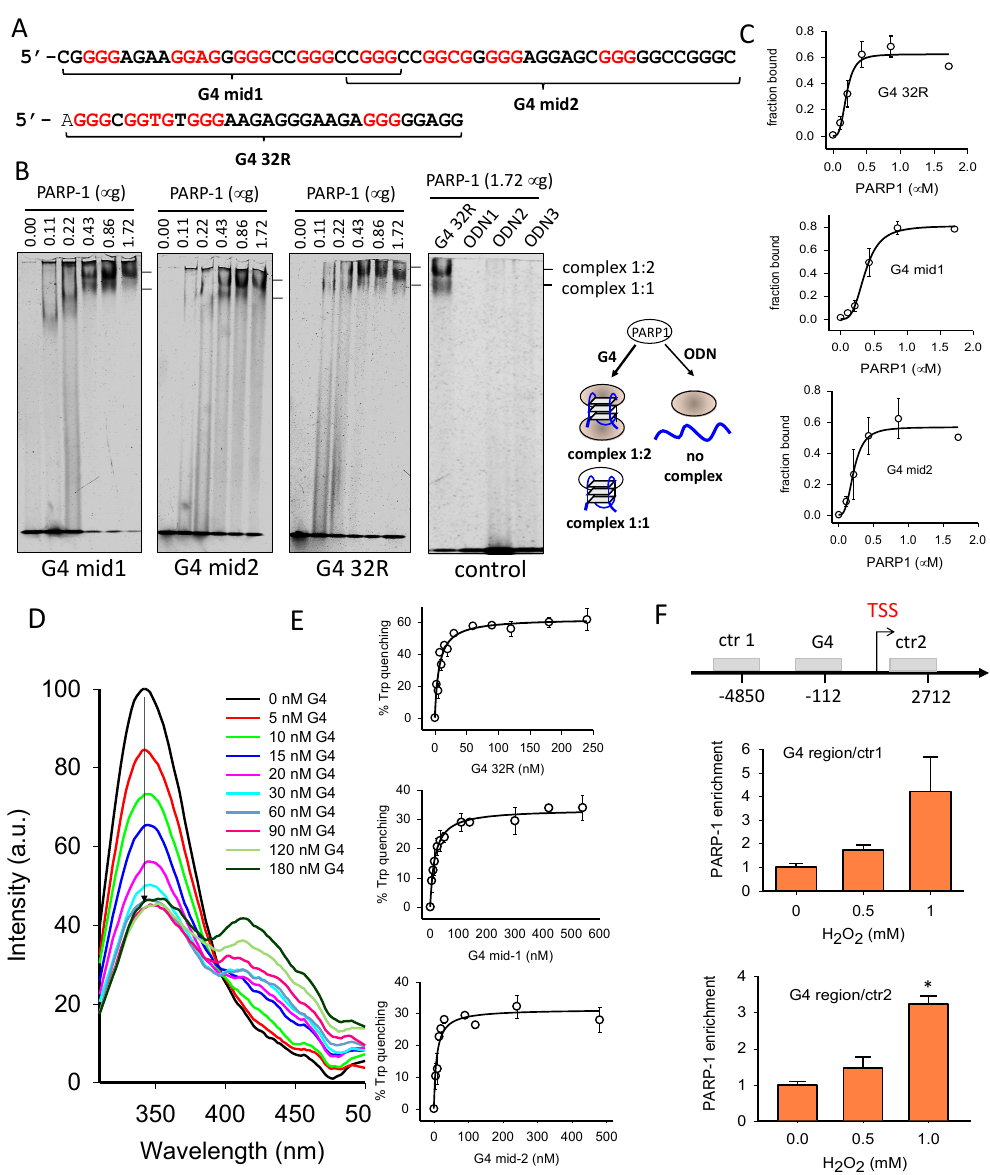
Figure 3. ( A ) Sequences of G4 32R, G4 mid1 and G4 mid2; ( B ) EMSA showing the binding of recombinant PARP-1 to Cy5.5-labelled G4-mid1, G4 mid2, G4 32R and control oligonucleotides ODN1, ODN2 and ODN3 (50 nM), with increasing amounts of PARP-1. Reaction was carried out in 20 mM Tris–HCl pH 8, 30 mM KCl, 1.5 mM MgCl 2 , 1 mM DTT, 8% glycerol, 1% Phosphatase Inhibitor Cocktail I (Sigma, Milan, Italy), 5 mM NaF, 1 mM Na 3 VO 4 , 2.5 ng/mL poly [dI-dC], 50 mM ZnAc for 30 min at RT. 50 nM Cy5.5-labelled G4 was incubated with 0, 0.11, 0.22, 0.43, 0.86, and 1.72 μM PARP-1; ( C ) Plots reporting the fraction of G4 bound to PARP-1 as a function of the PARP-1 concentration. The data have been best-fitted to the Hill equation. Error bars are from two experiments; ( D ) Typical fluorescence titration of PARP-1 with G4 32R. The titration was carried out in a 500 µ L quartz cuvette containing a solution of PARP-1 (60 nM) in 50 mM Na-cacodylate, pH 7.4, 100 mM KCl, 50 µ M ZnAc, 1 mM DTT. G4 32R was added to the PARP-1 solution and the readings were performed 5 min after incubation. The fluorescence spectra were recorded at 20 ◦ C between 310 and 500 nm, excitation at 295 nm. Titrations were carried out also with G4 mid1 and G4 mid2; ( E ) Plots reporting the % Trp quenching induced by increasing amounts of G4 32R, G4 mid1, and G4 mid2. Error bars are from two experiments; ( F ) ChIP showing the recruitment of PARP-1 to the G4 promoter region compared to non-G4 control ctr1 and ctr2 regions, following H 2 O 2 treatment of Panc-1 cells. Error bars are from three experiments, (*) = p <